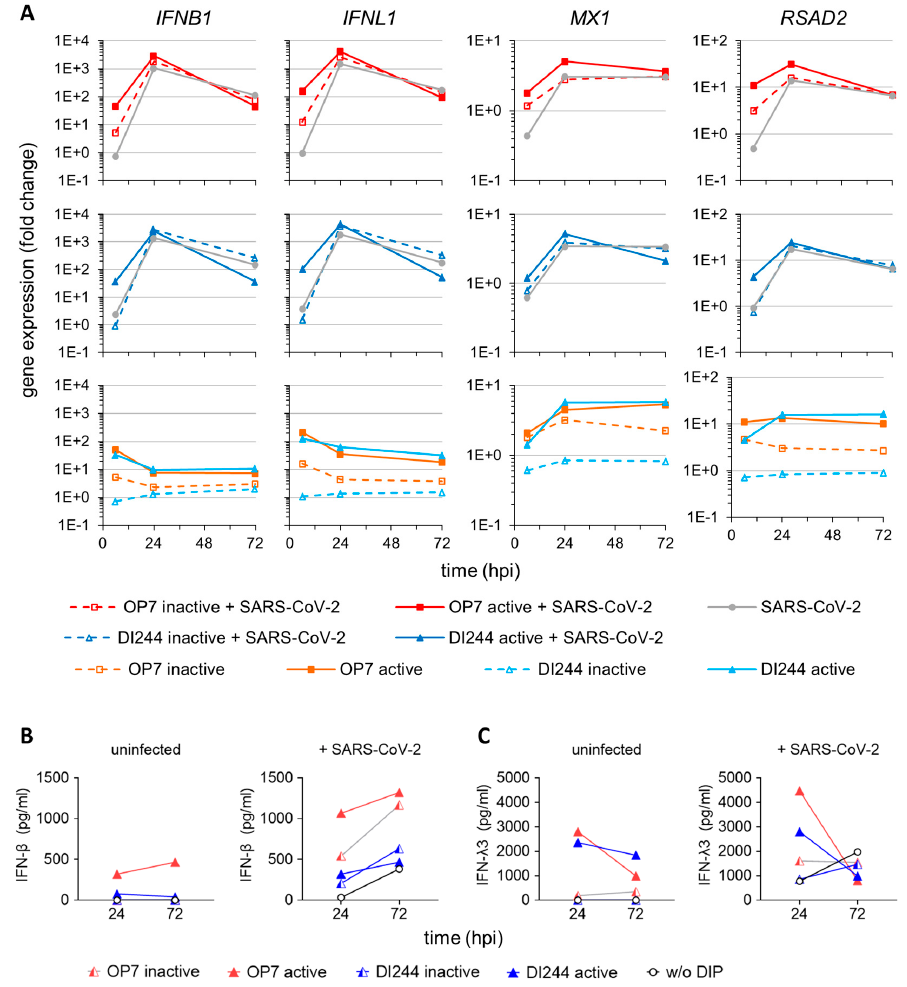
Figure 3. Stimulation of IFN-induced antiviral activity by IAV DIP infection. SARS-CoV-2-infected Calu-3 cells (MOI = 0.03) were treated with IAV DIPs (DI244 or OP7) at 1 hpi. For DI244 and OP7 infection, 10% ( v / v ) (100 μ L culture volume) of highly concentrated cell culture-derived DIP material was used [29,30]. At indicated times post-infection, infected cells were lysed to allow for total RNA extraction, required for ( A ) gene expression analysis. In addition, supernatants were sampled for ( B , C ) quantification of secreted IFNs. Illustration includes data from one experiment. ( A ) Gene expression analysis of SARS-CoV-2 and IAV DIP co-infection. Transcript levels were quantified by real-time RT-qPCR and expressed as fold change (relative to untreated, uninfected cells). MX1, MX dynamin-like GTPase 1; RSAD2, radical S-adenosyl me- thionine domain-containing 2. ( B , C ) Host cell IFN production. Protein levels of IFN- β ( B ) and IFN- λ 3 ( C ) were assessed using ELISA.